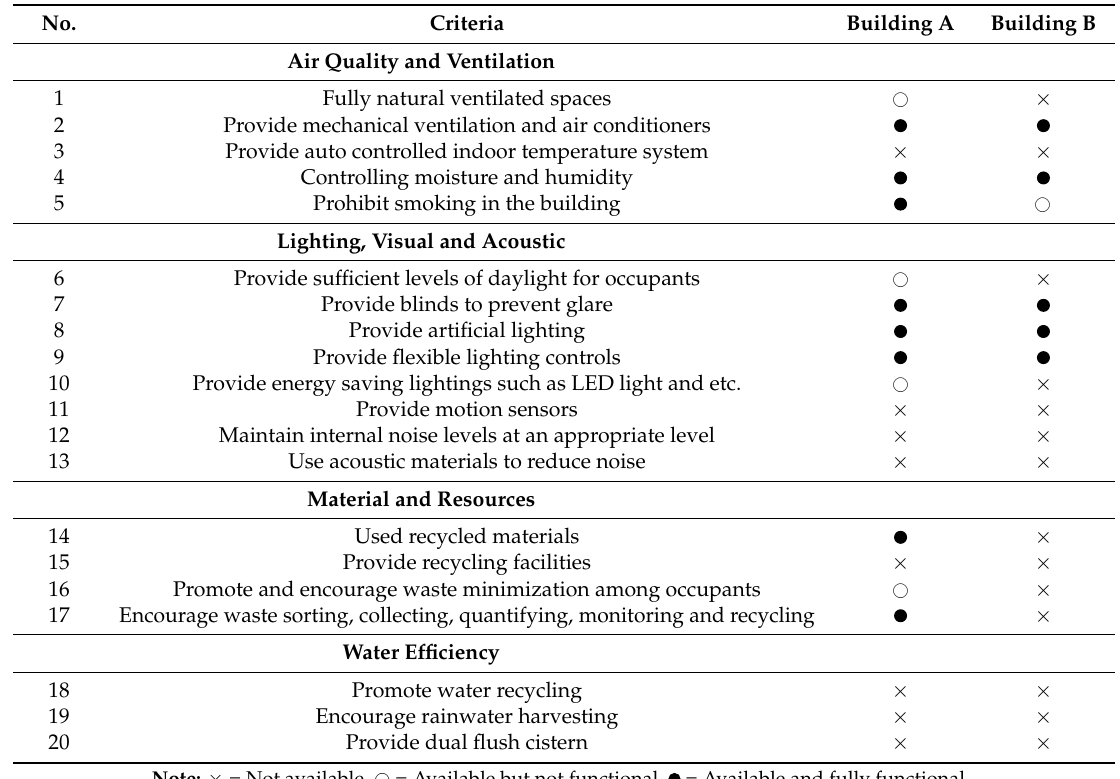
Table 1. Indoor environmental assessment in Building A and Building